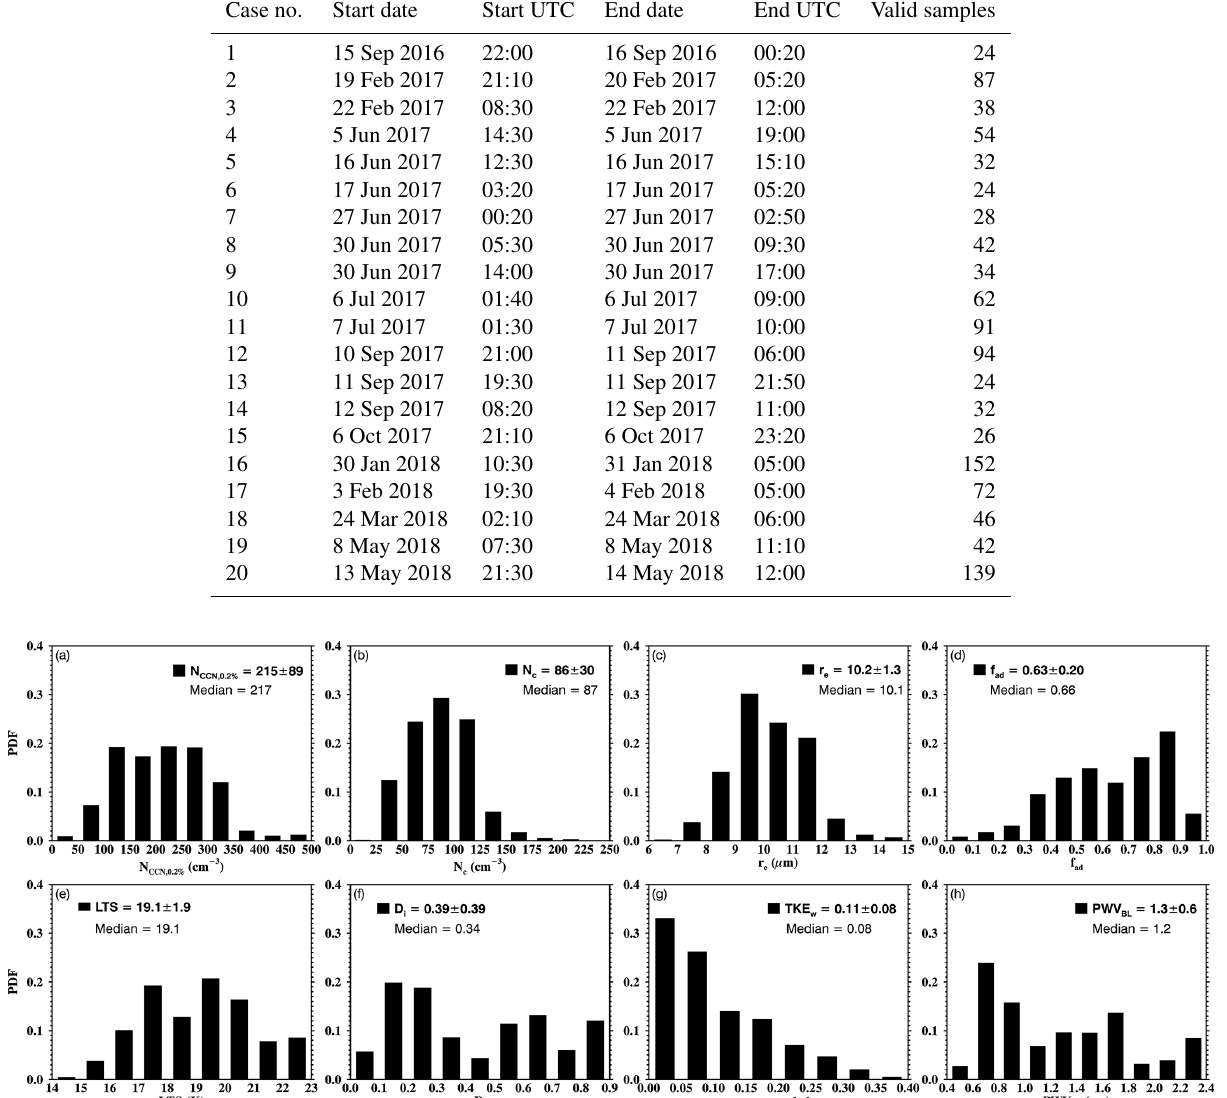
Figure 1. Probability distribution functions (PDFs), mean, standard deviation, and median values of aerosol, cloud, and meteorological properties for 20 selected non-precipitating cloud cases at the DOE ENA site during the period 2016–2018. (a) Cloud condensation nuclei (CCN) number concentration at 0.2% supersaturation ( N CCN , 0 . 2% ); (b) cloud droplet number concentration ( N c ); (c) cloud droplet effective radius ( r e ); (d) cloud adiabaticity ( f ad ); (e) lower tropospheric stability (LTS); (f) decoupling index ( D i ); (g) mean vertical component of turbulence kinetic energy (TKE w ); (h) sub-cloud boundary layer precipitable water vapor (PWV BL